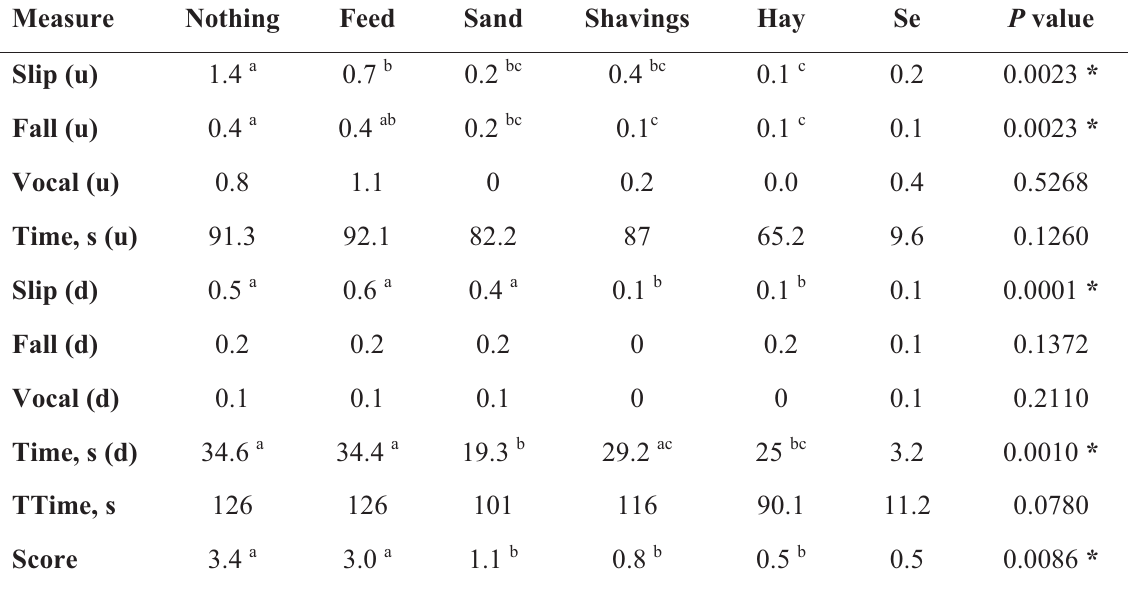
Table 1. Least Squares means accompanied by pooled standard error for slips, falls, vocalizations, time (sec), total time (TTime: sec) and score for weaned pigs during loading (U) and unloading (D) with the use of different bedding